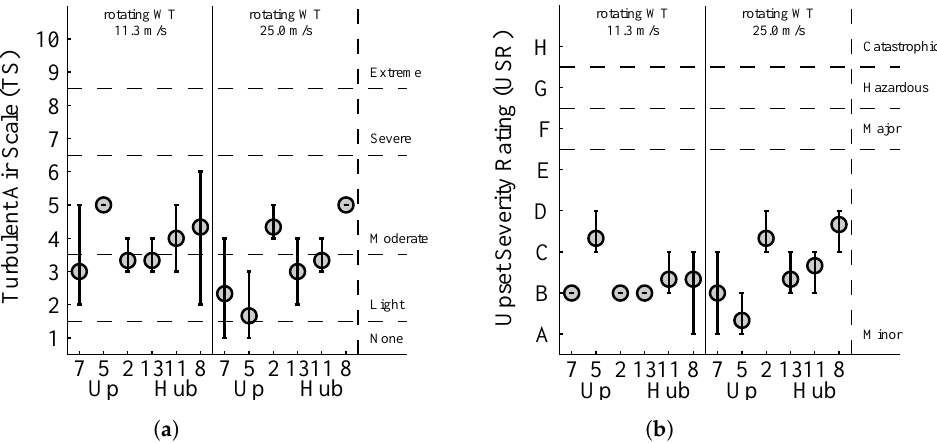
Figure 23. Subjective pilot assessment of the transit task at different positions (Up—altitude upper boundary, Hub—altitude hub height). ( a ) Turbulent Air Scale (TS, Table A2); ( b ) Upset Severity Rating (USR, Figure